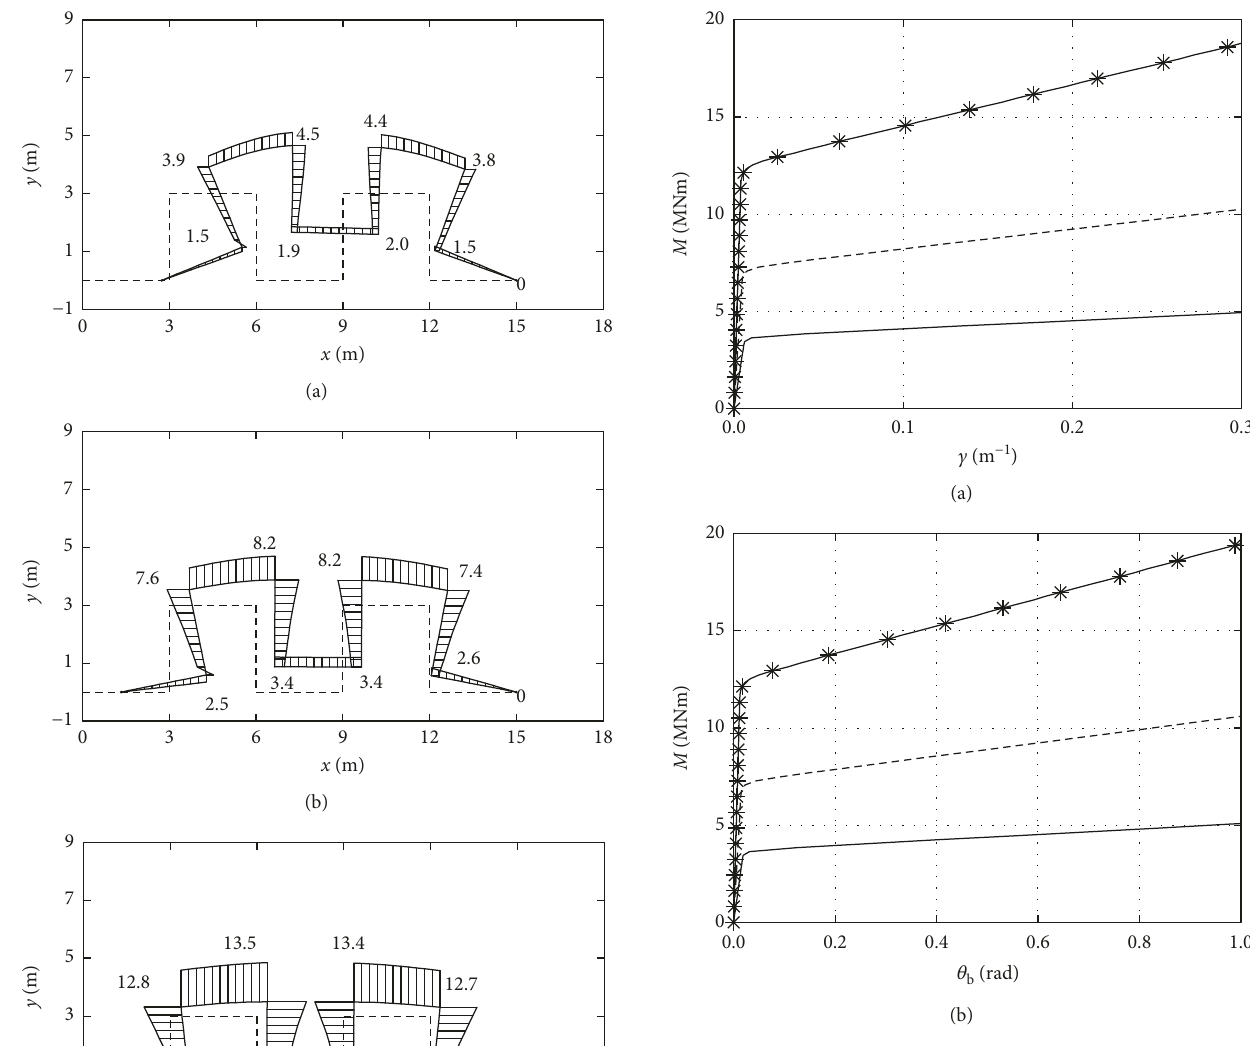
Figure 9: Moment-curvature relationships of the I cross sections (a) and moment-rotation relationships of single steel beams (b) corresponding to different beam cross-section